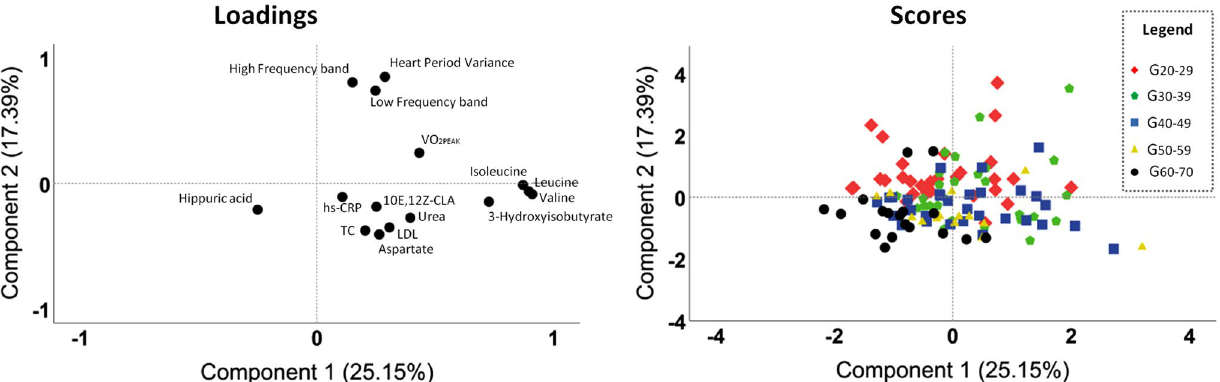
Figure 2. Principal component analysis in significant variables. 10E,12Z-CLA 10E,12Z-octadecadienoic acid,